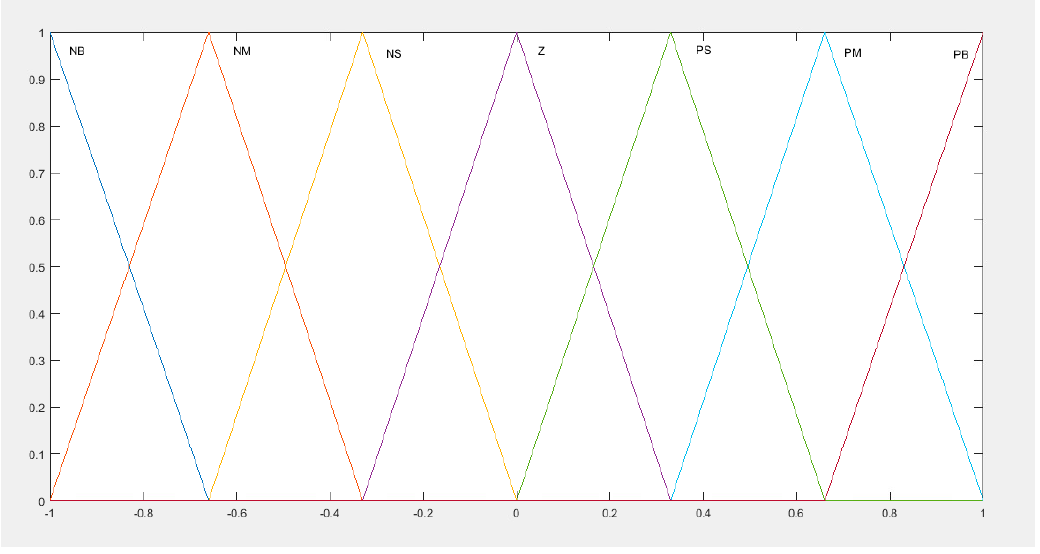
Figure 3. Input membership functions.